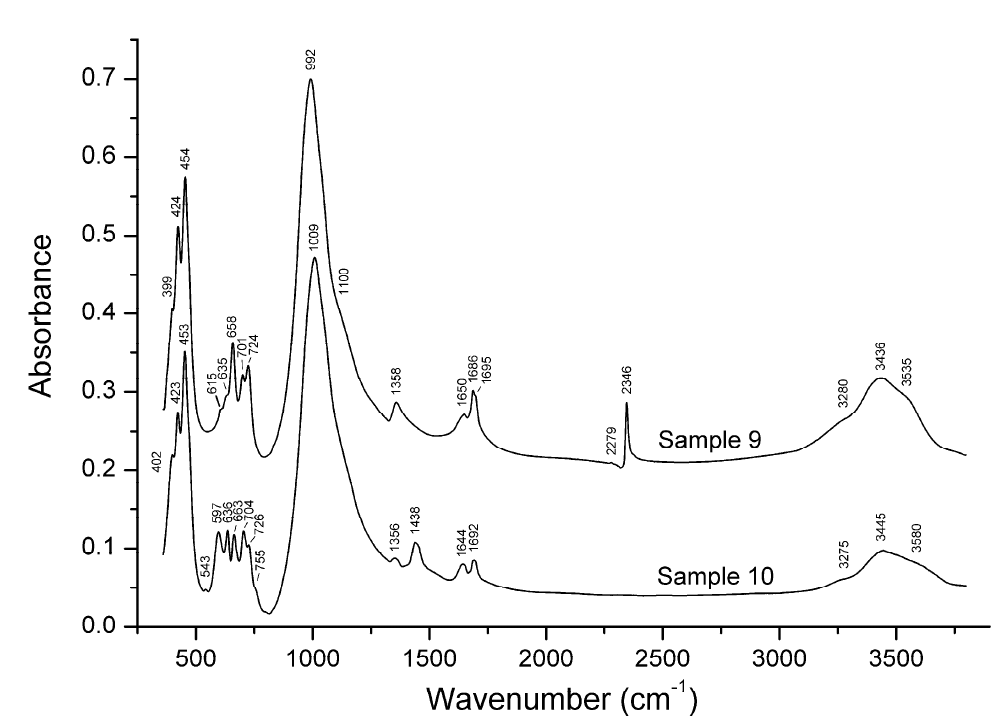
Figure 7. Infrared absorption spectra of the sulfate-poor minerals belonging to the haüyne–lazurite solid-solution series (Samples 6 to 8).